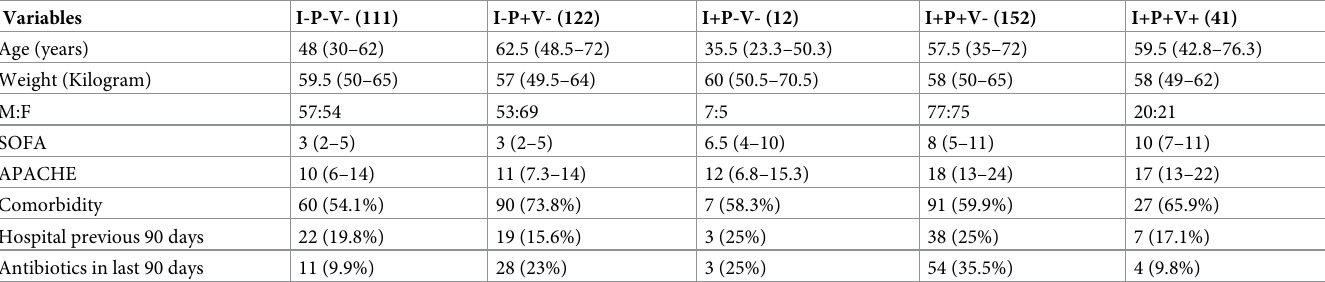
Table 1. Baseline characteristics of patients enrolled in the study.